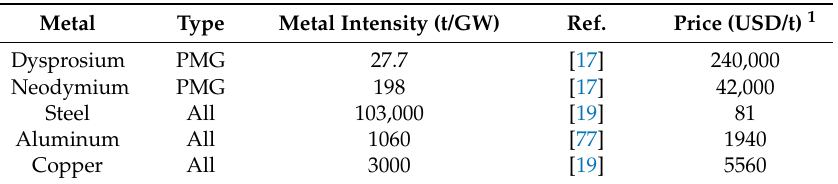
Table 5. Metal intensity in wind power.